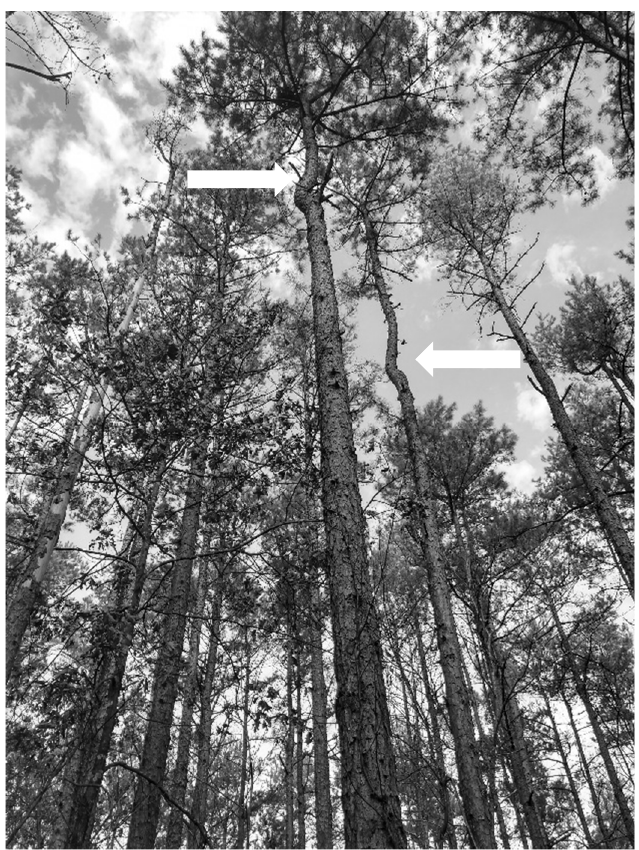
Figure 2. Shortleaf pine with (probably ice) storm damage in a progeny test in the Ouachita National Forest. The main leader in these mature trees was broken, likely by the same event, years earlier, resulting in a “crook” bole and spike knot (arrows). Photograph by Shaik Hossain.